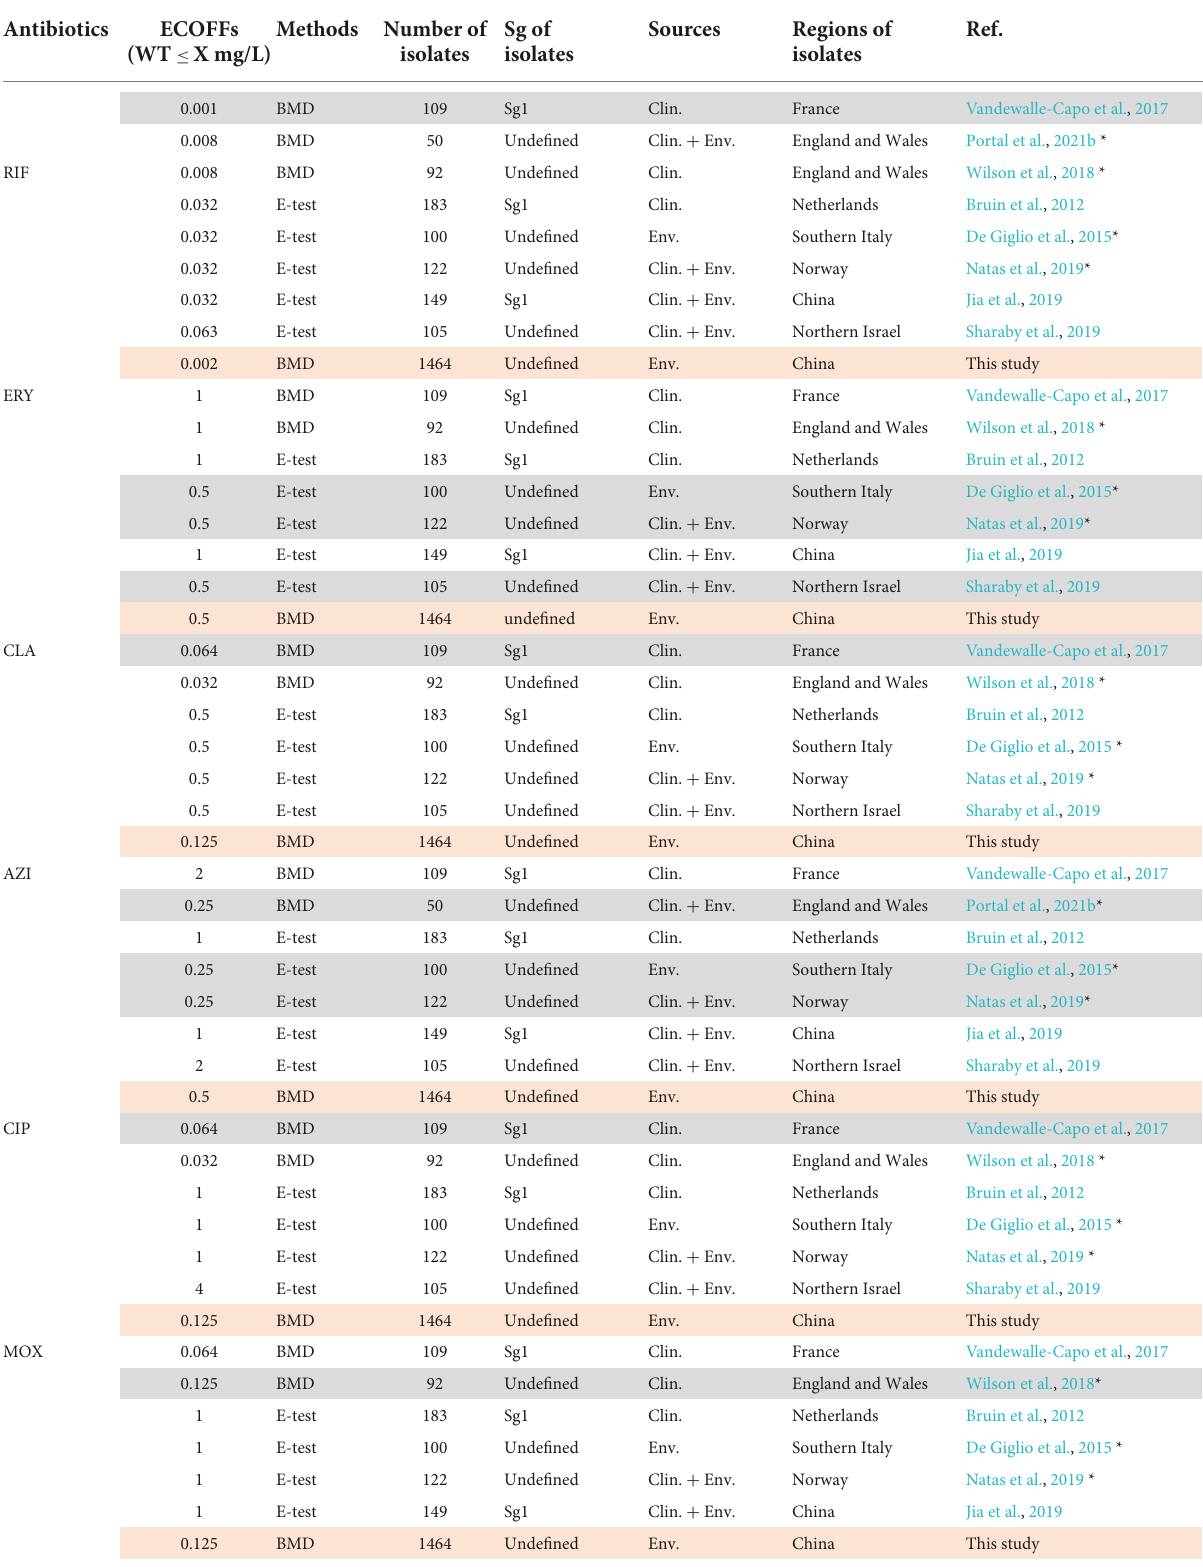
TABLE 3 Epidemiological cutoff values (ECOFFs) of antimicrobials for L. pneumophila that are described in other articles. Antibiotics ECOFFs Methods Number of Sg of (WT ≤ X mg/L) isolates